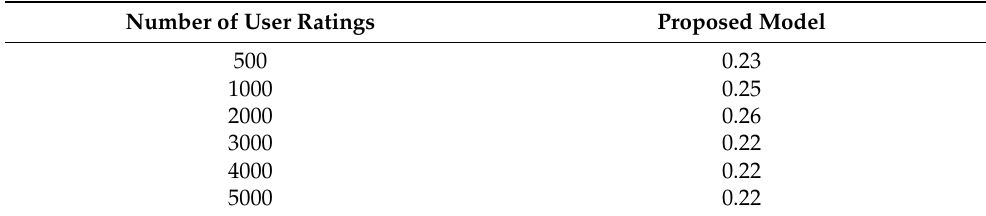
Figure 4. Distribution of similarity index for all users in a group. Table 3. MAE according to the sizes of the testing